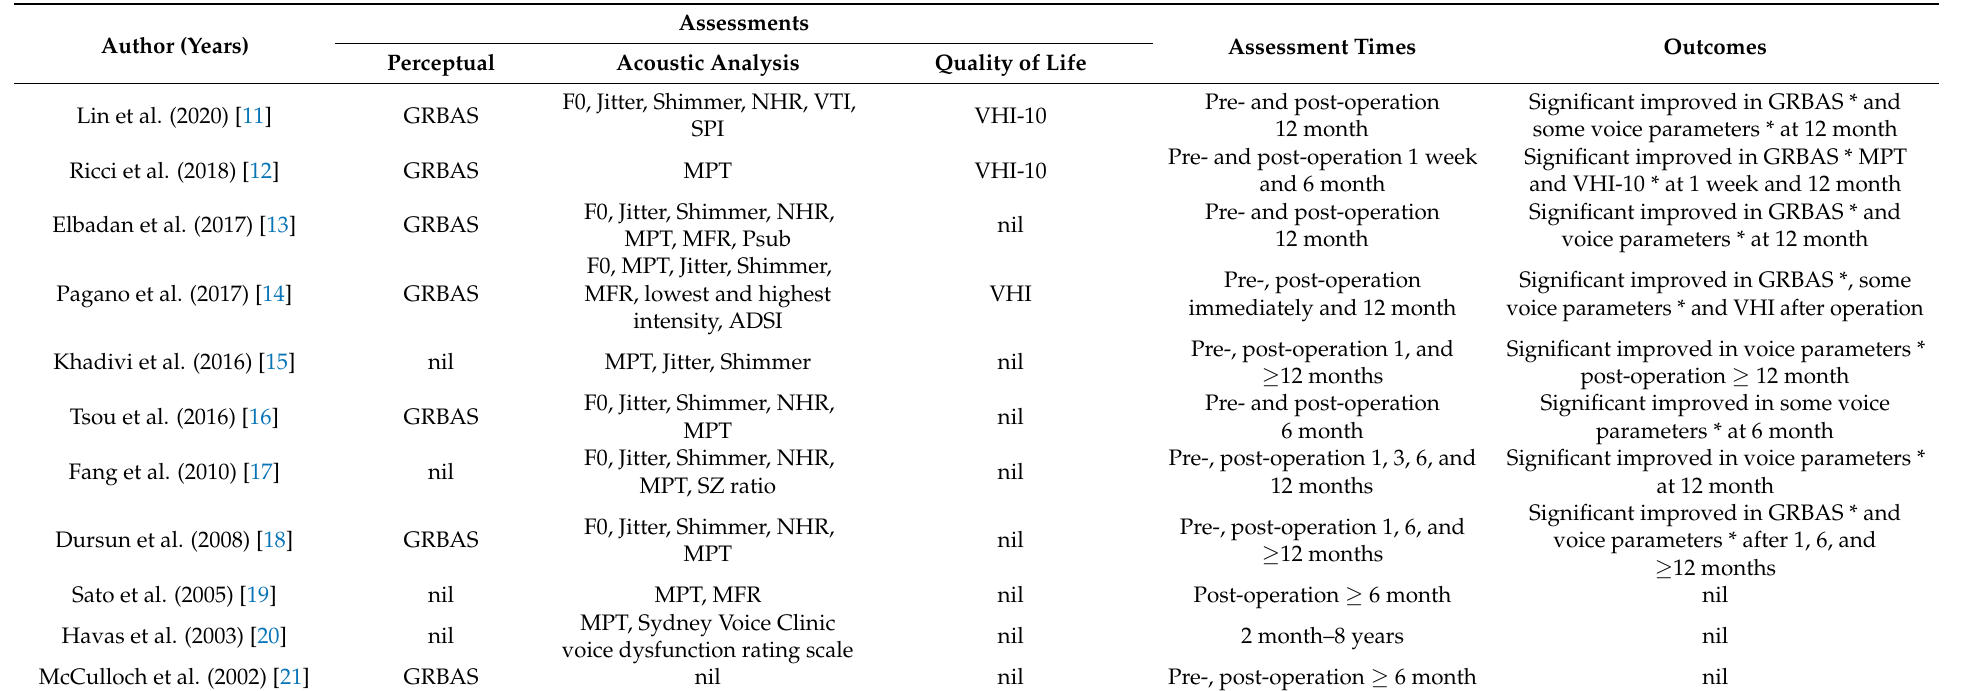
Table 2. Summary of the assessment, assessment time and outcomes in 11 included